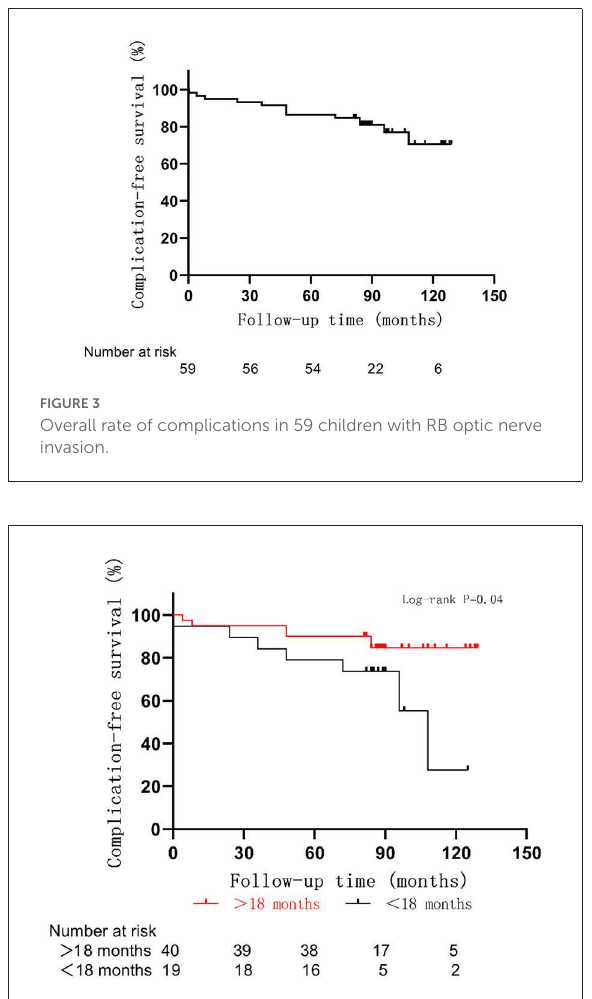
FIGURE4 Rate of complications by age group in 59 children with RB optic nerve